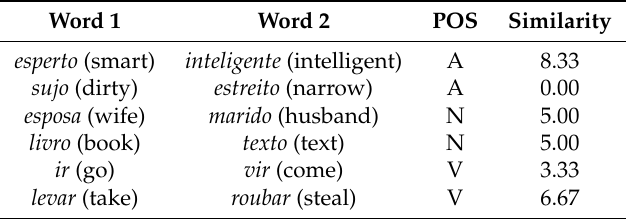
Table 12. First two adjectives, nouns and verbs of the Portuguese